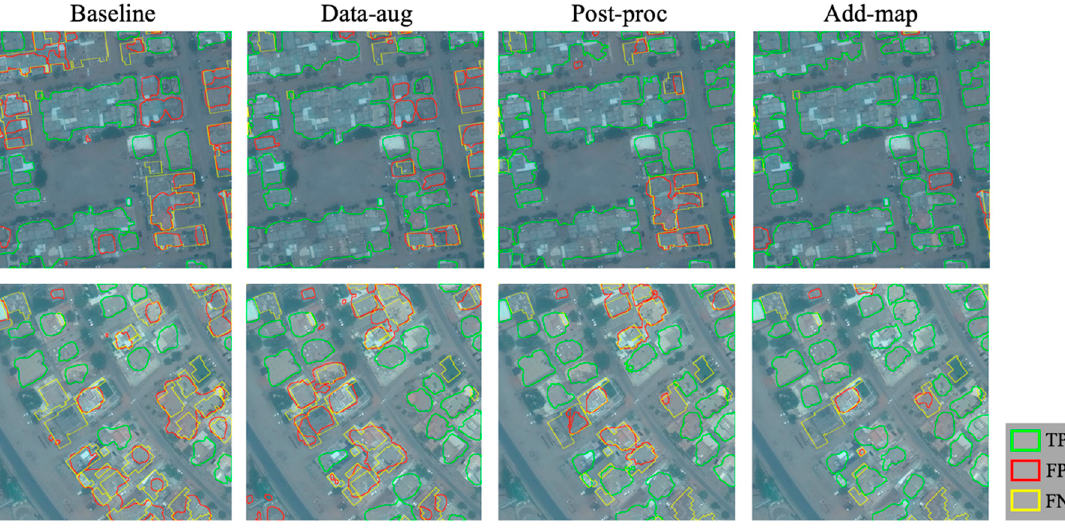
Figure 9. Examples of building extraction results for Khartoum using different strategies.